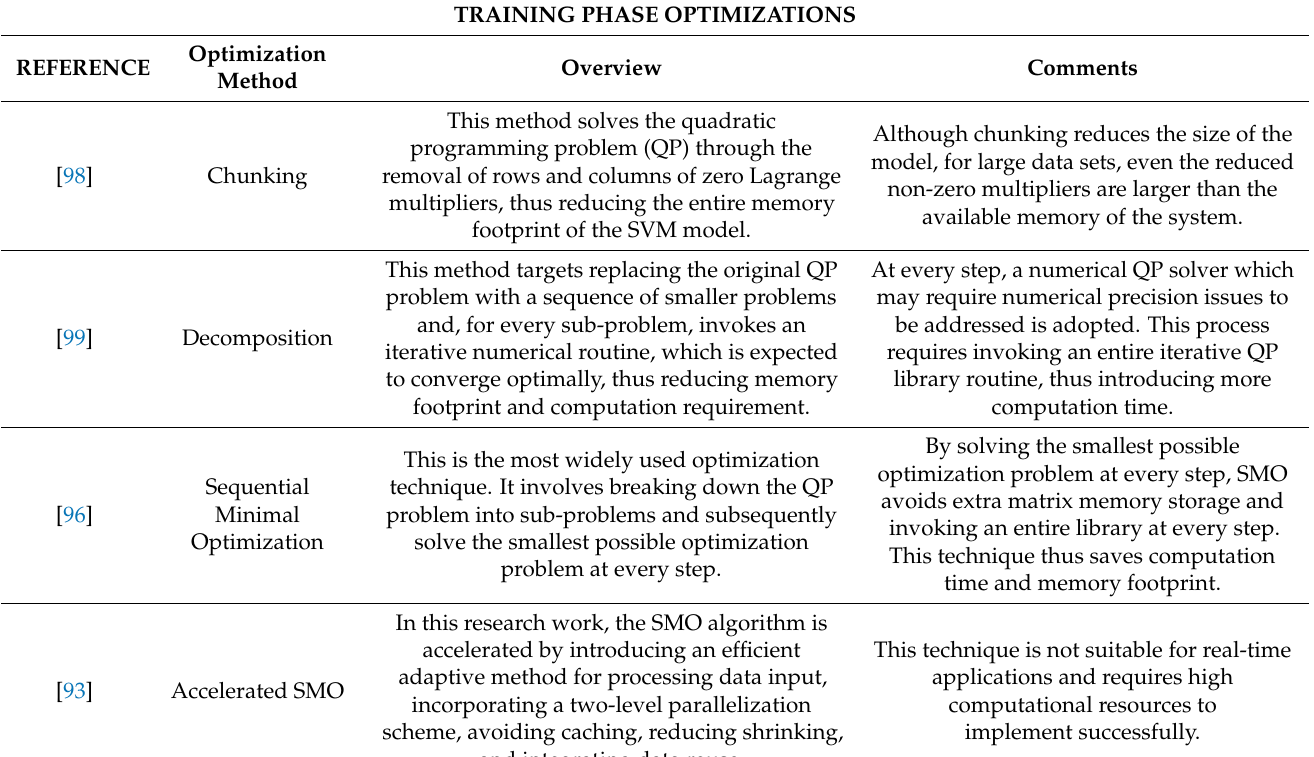
Table 7. SVM Optimization